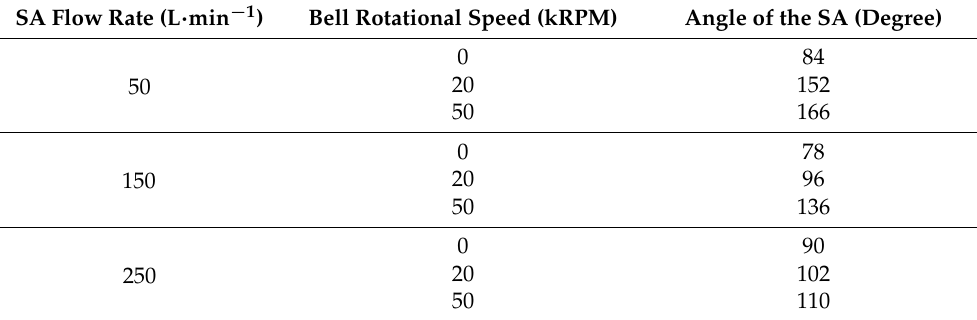
Table 2. Spray pattern angles of the SA for tested operating conditions.